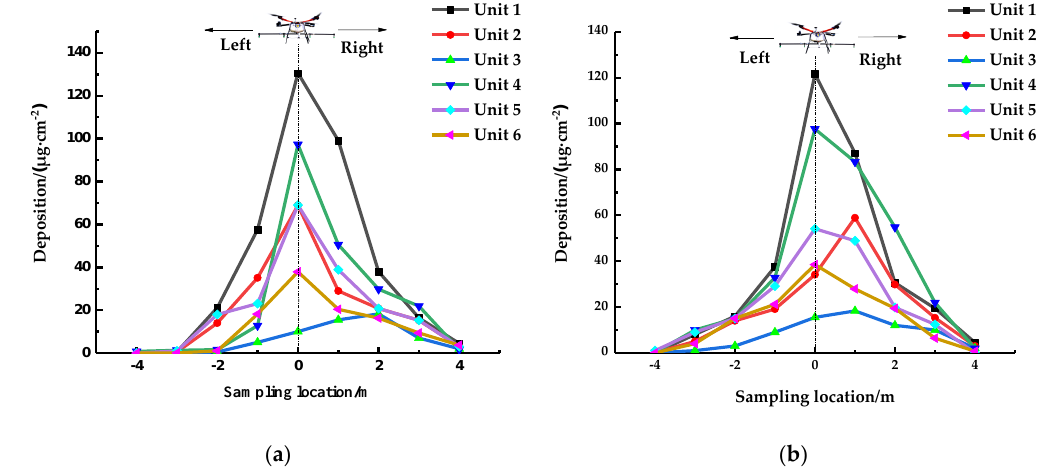
Figure 20. Droplet deposition in center line of operational unit: ( a ) third sortie; ( b ) fourth sortie.